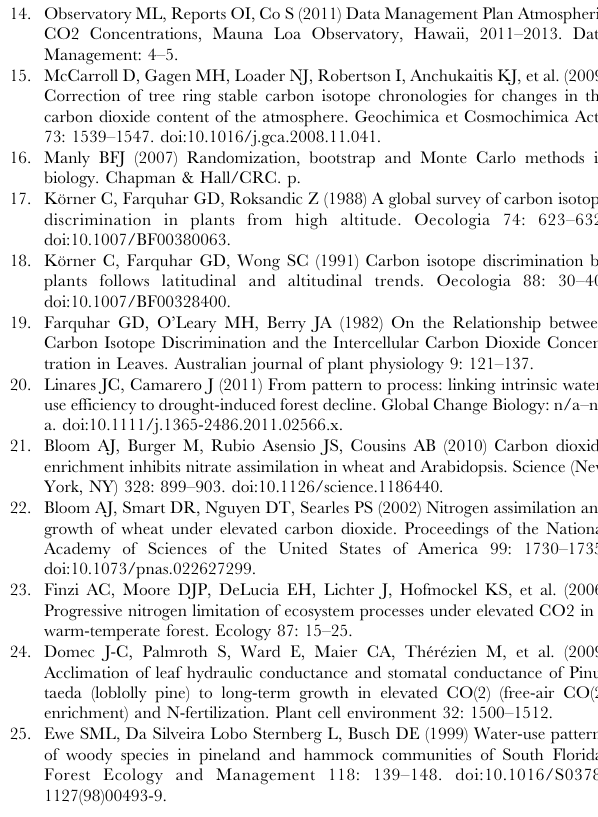
Table S1 List of case studies that reported physiological changes in response to rising atmospheric CO 2 .